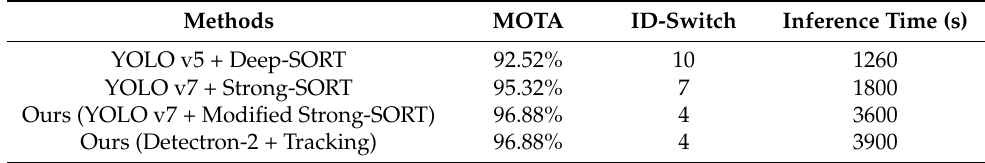
Table 9. A comparison of the Multi-Object tracking methods.